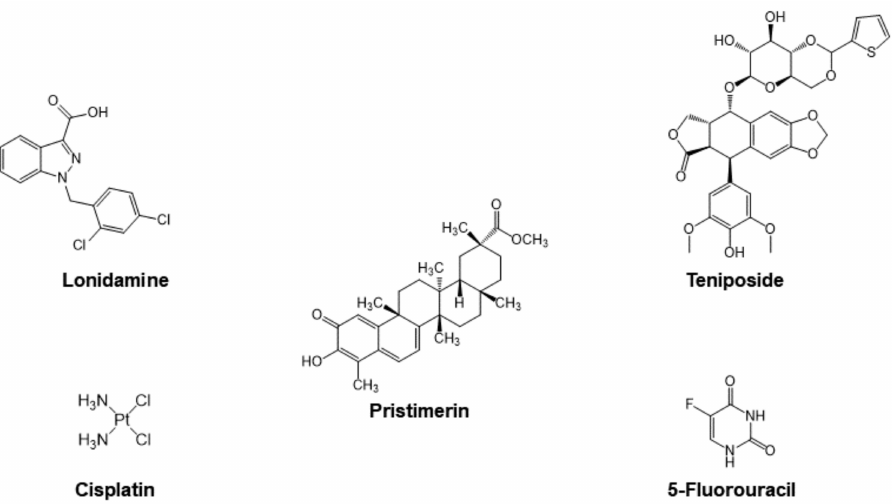
Figure 11. Small molecule anticancer drugs that involve Cyt c in their anticancer mechanism.